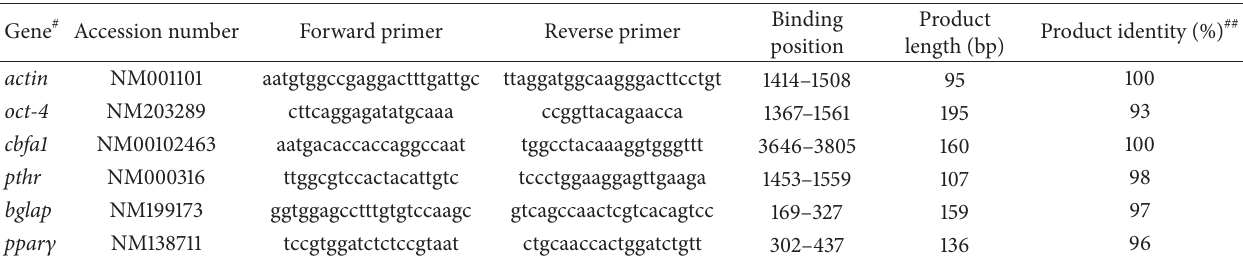
Table 1: Primer pairs used for real time